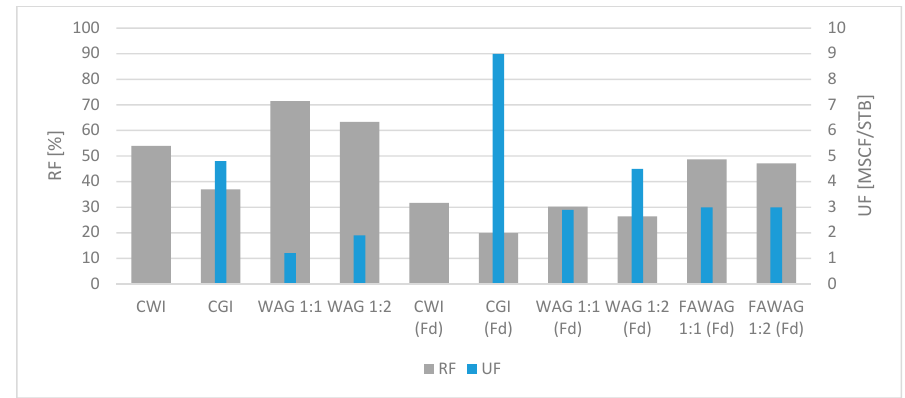
Figure 5. Comparison of Recovery Factor (RF) and gas Utilization Factor (UF) for all coreflooding experiments conducted in non-fractured as well as fractured (Fd) cores.